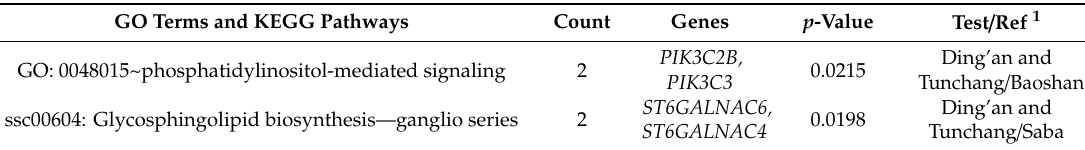
Table 3. Gene Ontology (GO) terms and Kyoto Encyclopedia of Genes and Genomes (KEGG) pathways enriched with candidate genes in Hainan pig